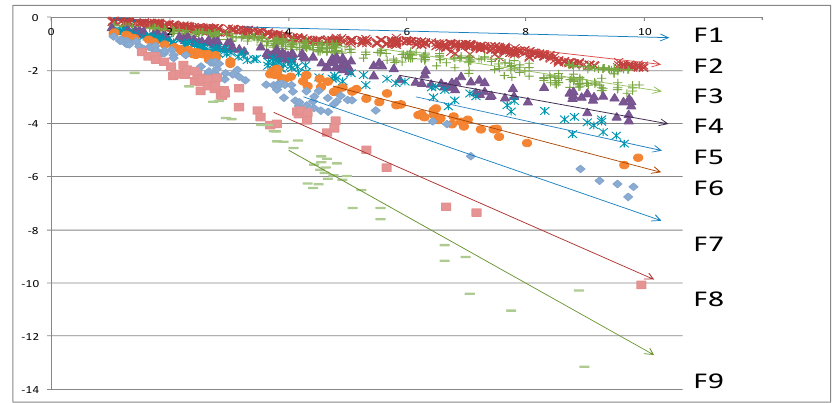
Figure 11. CRiPS-plot of credit risk (Crisk) classes in fixed interval scheme (FIS).